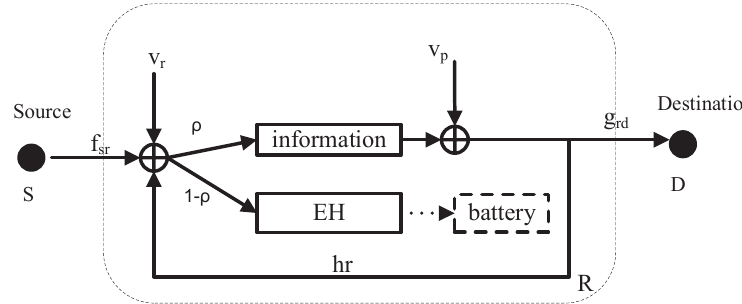
Figure 4. Full-duplex EH